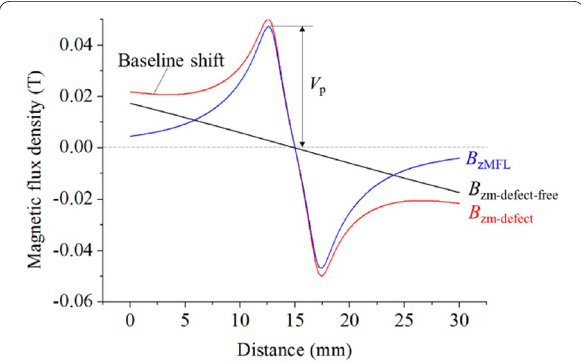
Figure 4 The normal components of magnetic field along the collecting line